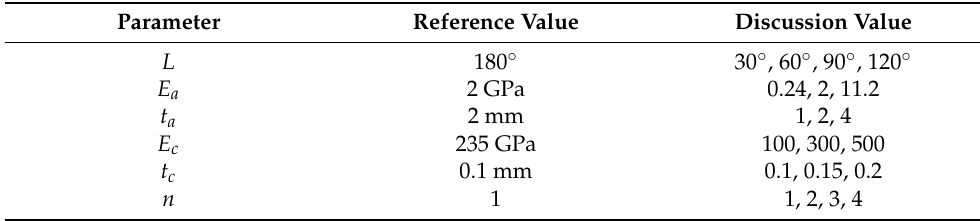
Table 5. Parameter